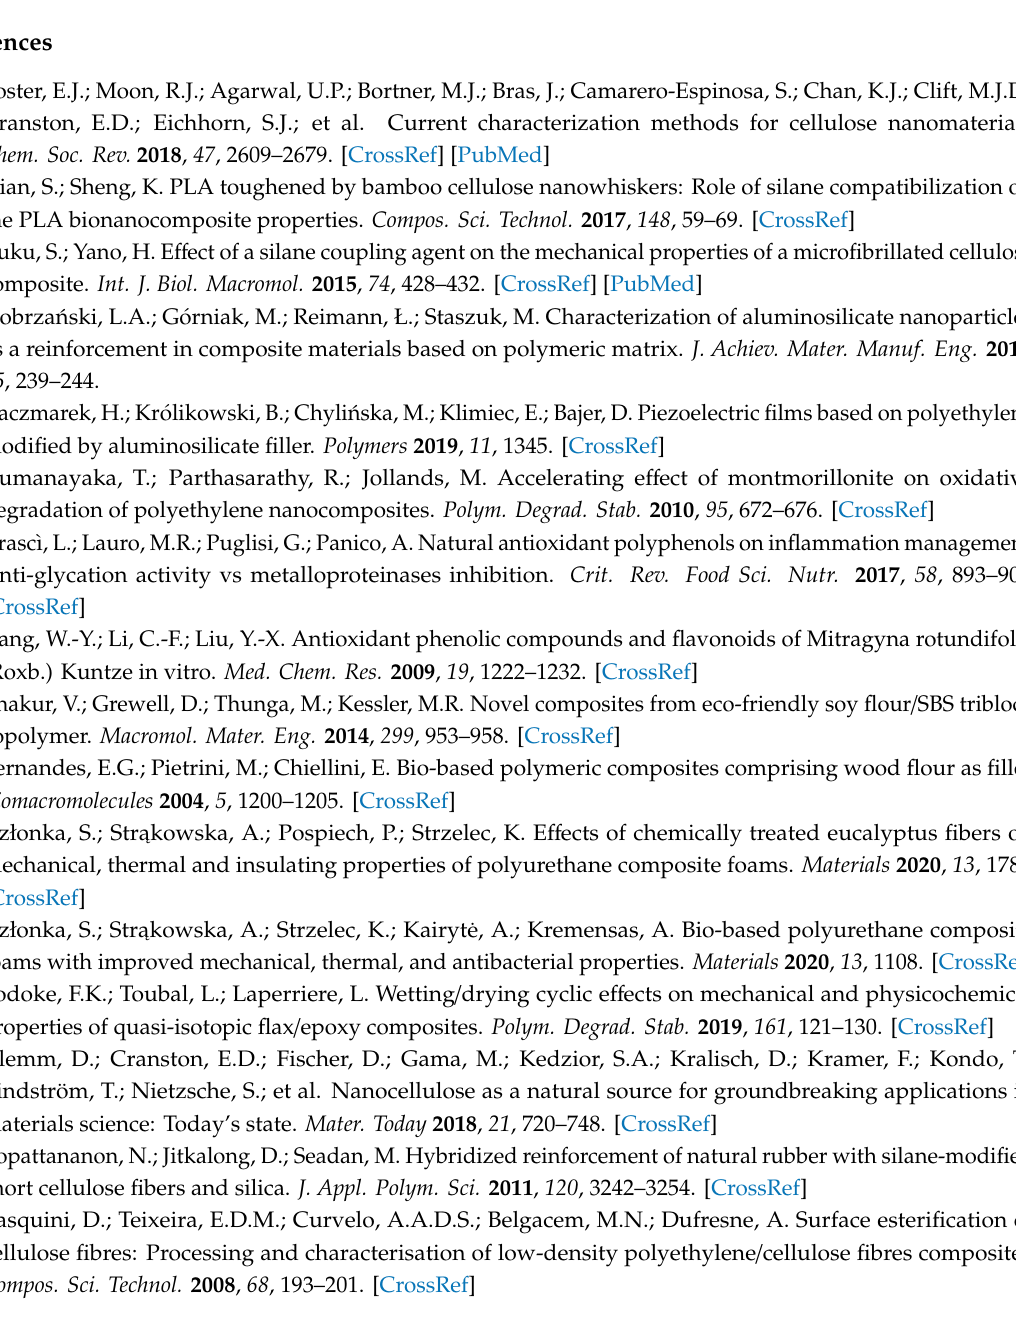
Figure S1: Near infrared spectra of: a) cellulose fibres modified via a solvent-involving method; b) cellulose fibres modified via a non-solvent method. Characteristic absorption bands: 8200–8100 cm − 1 (C–H), 6770 cm − 1 (O–H), 6715 cm − 1 (O–H, water), 4750 cm − 1 (O–H). Table S1: Tabularized absorption bands assigned to the chemical